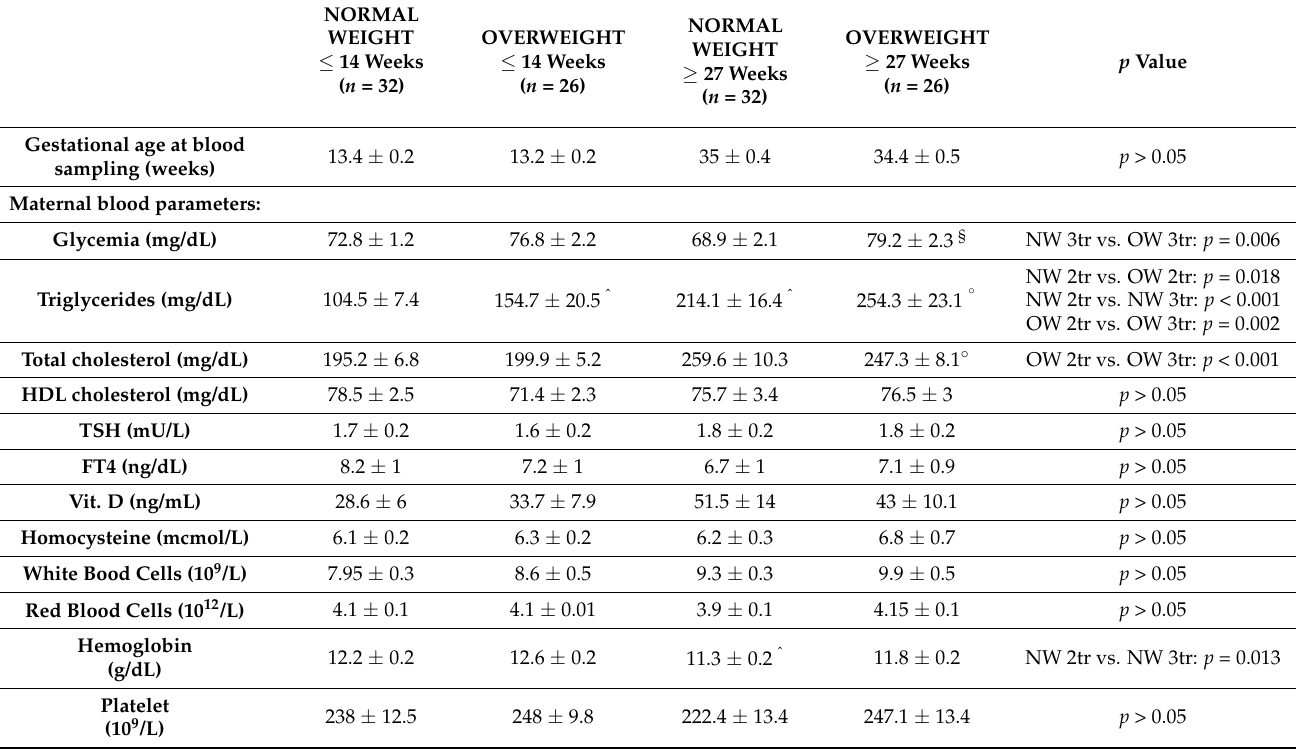
Table 2. Maternal hematological parameters in normal weight and overweight women in early second trimester and third trimester pregnancies. Values are expressed as mean ± SE and percentage. Significant differences ( p < 0.05): ˆ differences indicating a significant effect compared with NORMAL WEIGHT 2tr; ◦ differences indicating a significant effect compared with Homologous Overweight 2tr; § differences indicating a significant effect compared with Homologous Normal Weight 3tr. One-way ANOVA with Bonferroni’s post hoc test was